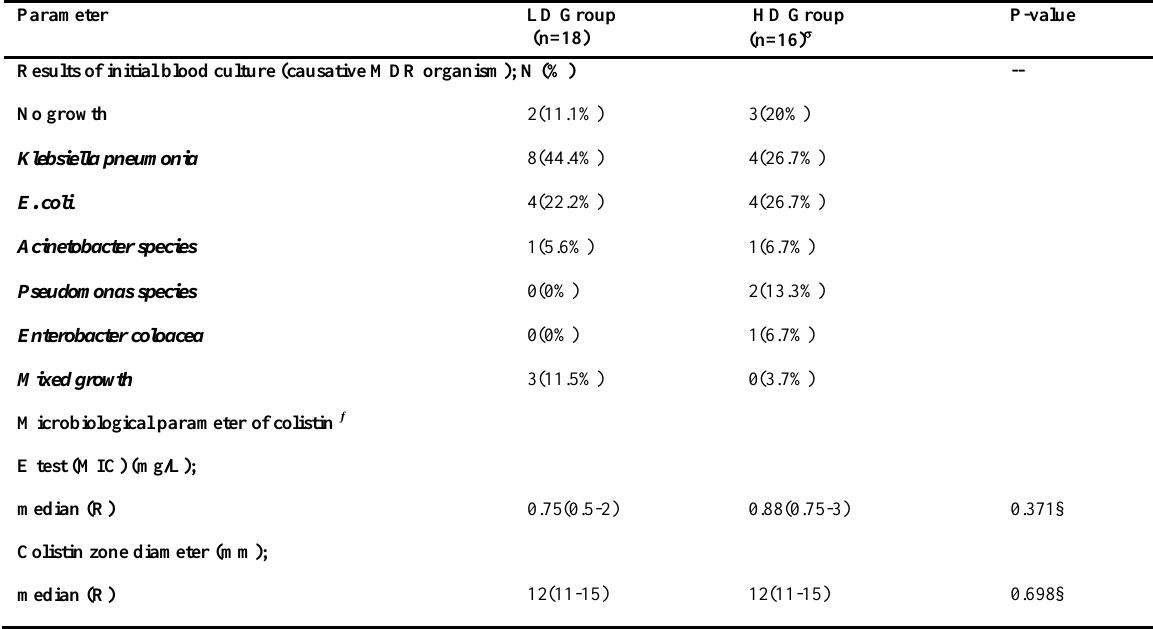
Table 2. Baseline Microbiological Data of Pediatric Cancer Patients with Febrile Neutropenia